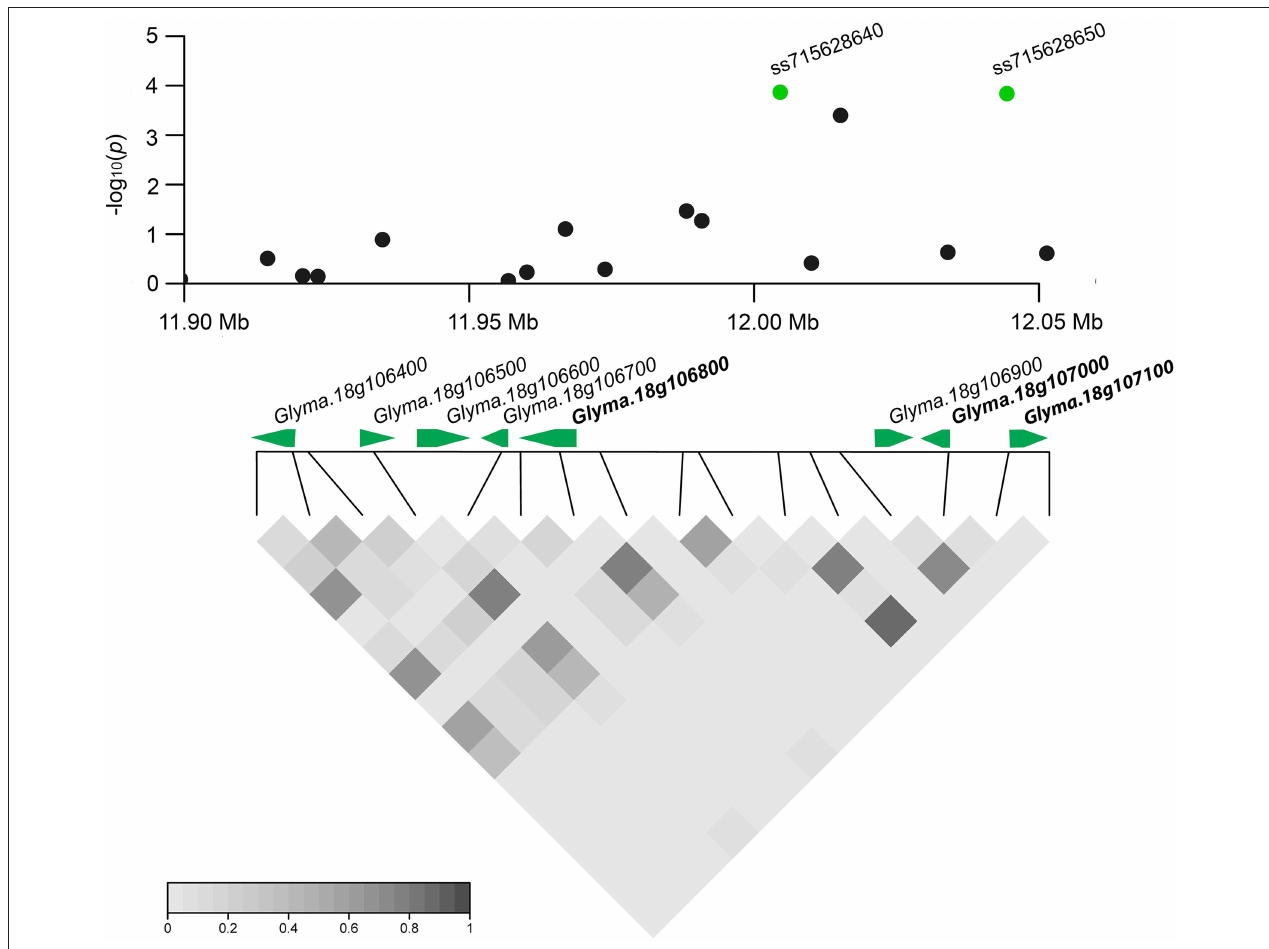
FIGURE 4 | Regional plot and candidate genes for loci ss715628640 and ss715628650. The log10-tranformed P -values of two association SNPs and adjacent loci are plotted against physical positions on chromosome 18. The middle panel shows all predicted gene models in the region. The proposed candidate genes are in bold. The bottom panel indicates the extent of LD in the region based on pairwise r 2 -values. The r 2 -values in the LD triangles are indicated with a color intensity